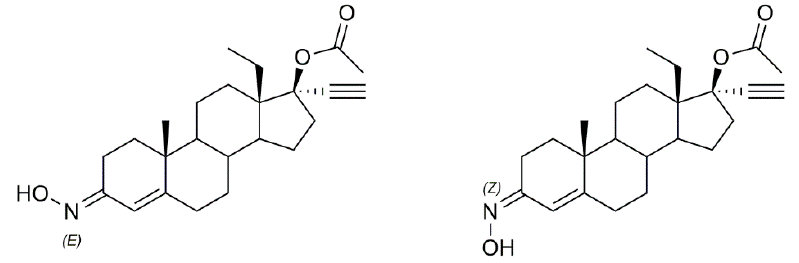
Figure 17. Norgestimate.